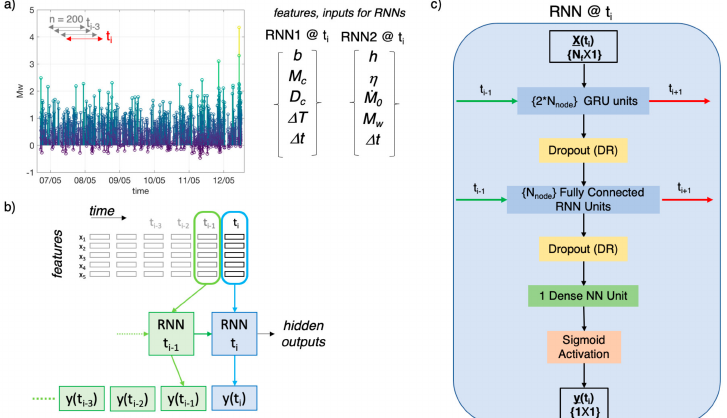
Figure 3. Overview of the recurrent neural network (RNN)-based preparatory phase prediction. ( a ) Computation of features on moving windows of n events. ( b ) Outline of the RNNs algorithms. ( c ) Outline of the RNN architecture at time t i